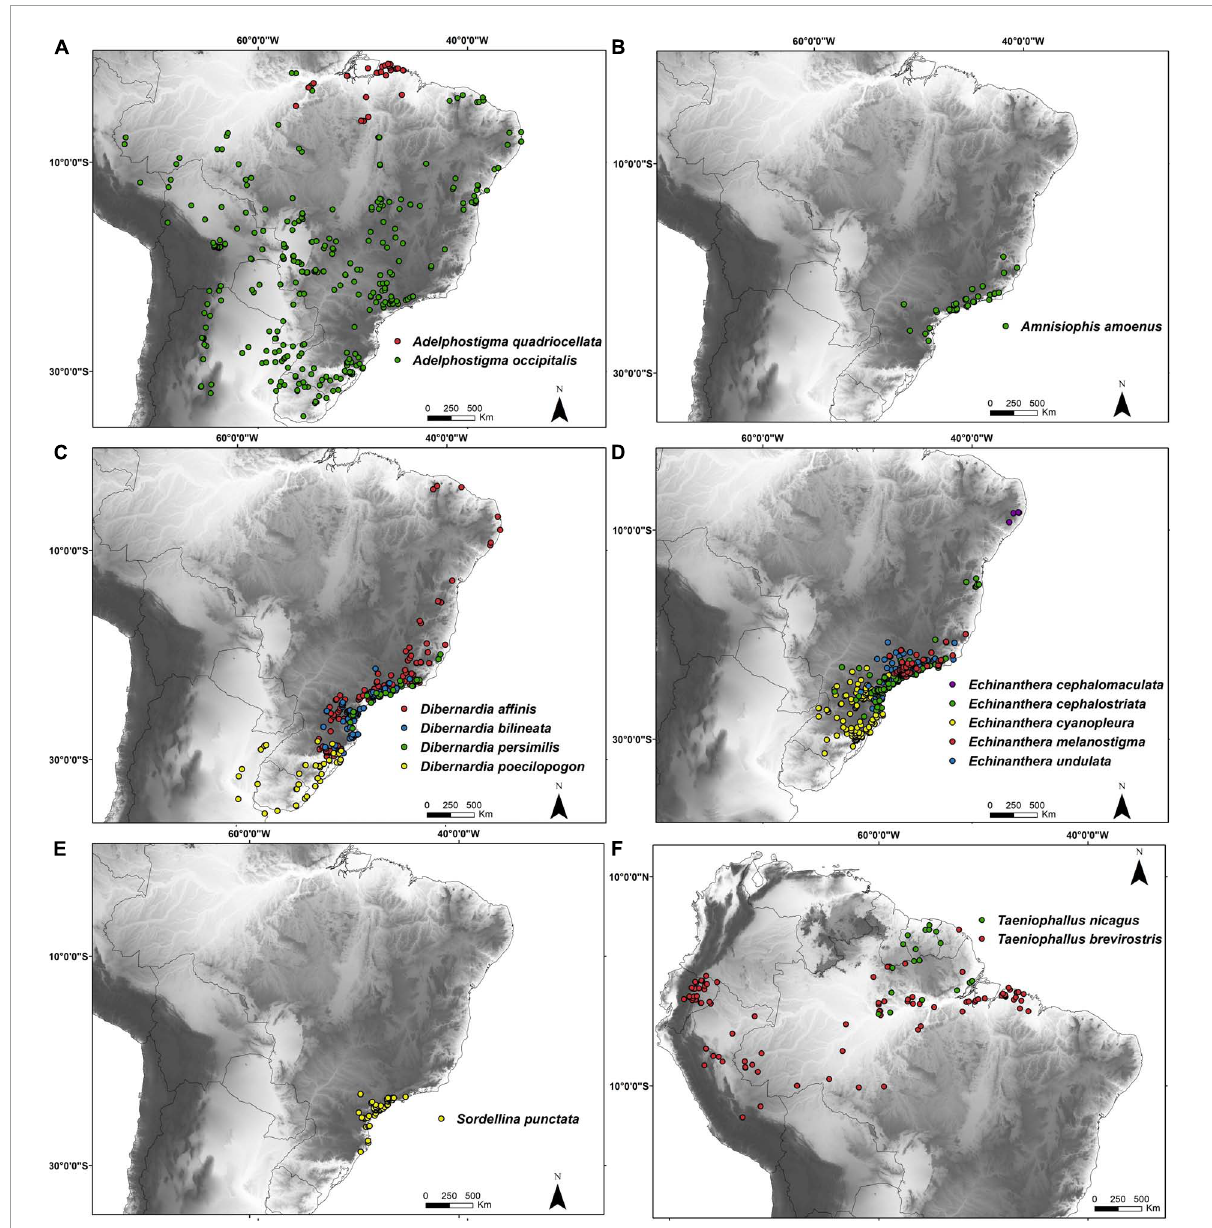
FIGURE6 Geographical distribution of Echinantherini according to the taxonomic rearrangement proposed in this study. Locality data are based on Nogueira et al. (2019). (A) Adelphostigma ; (B) Amnisiophis ; (C) Dibernardia ; (D) Echinanthera ; (E) Sordellina ; and (F) Taeniophallus .